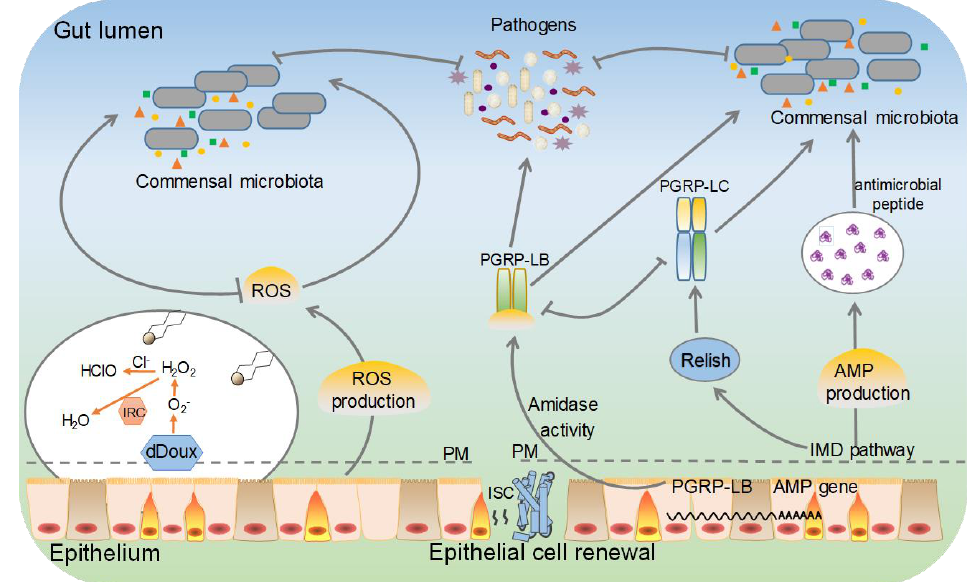
Figure 2. Putative immune signalling pathways are involved in the defences against pathogenic microbial infections in the gut of lepidopteran insects. This model is based on the local production of reactive oxygen species (ROS), and antimicrobial peptide (AMP) of Drosophila and findings in lepidopteran insects. The immune deficiency (IMD) includes the major signalling pathways inducing AMP production, and AMP genes provide inducible defense mechanisms in the gut. PM, peritrophic matrix.